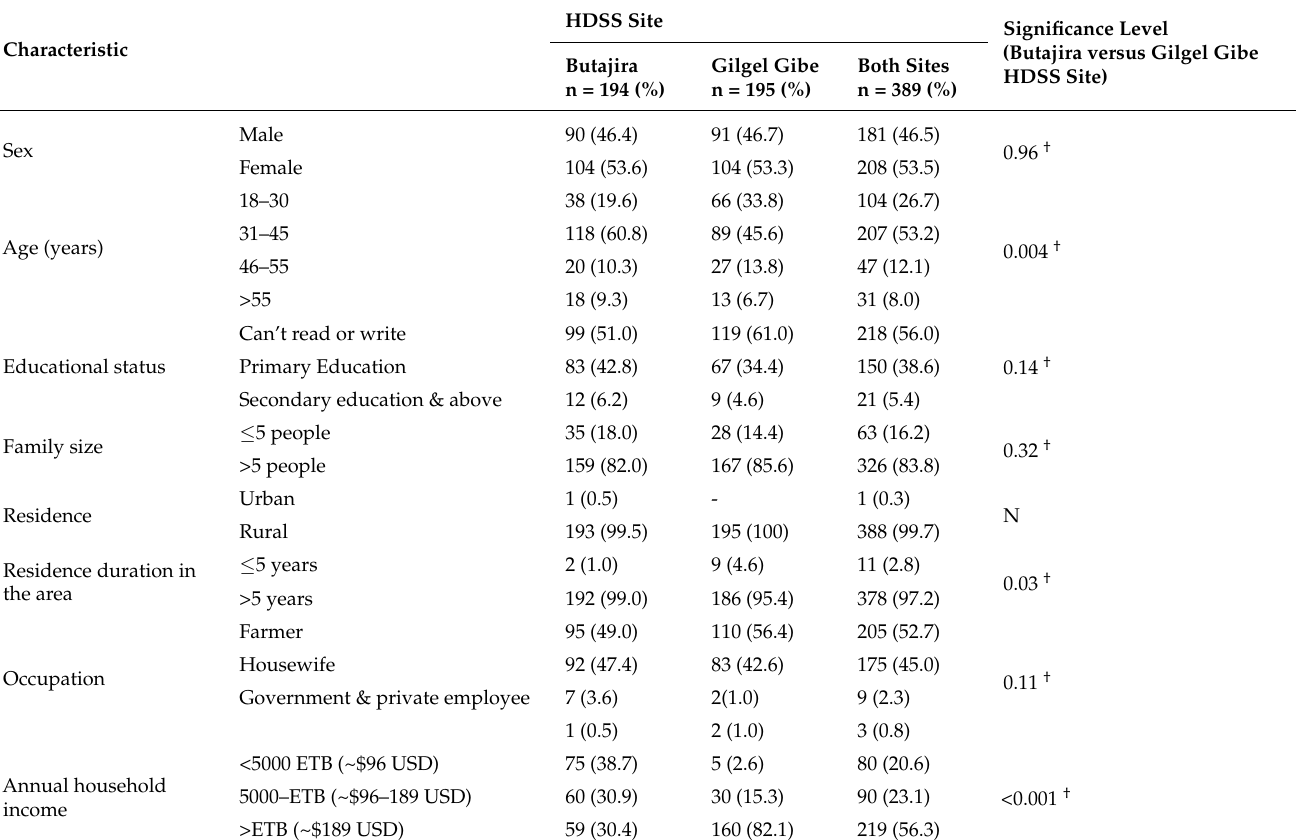
Table 1. Socio-demographic characteristics of questionnaire respondents in a study of fasciolosis in Butajira and Gilgel Gibe HDSS sites,